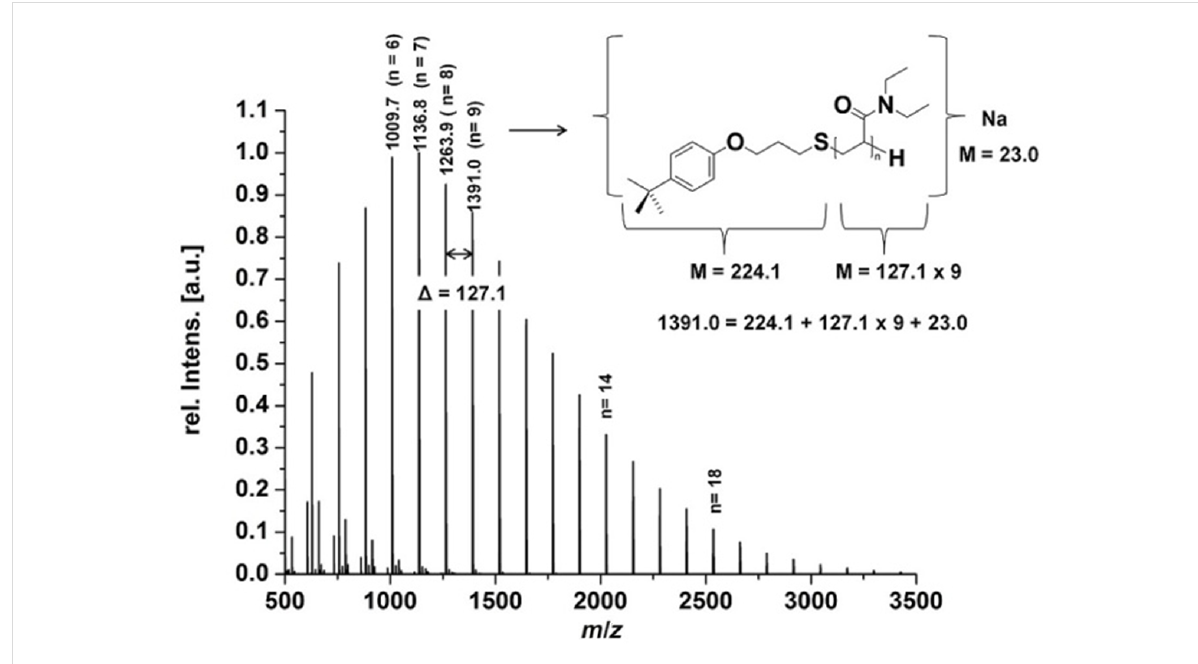
Figure 1: Section of the MALDI –TOF spectrum of polymer 8b , indicating the high degree of end-group functionalization by the use of free-radical chain transfer polymerization.